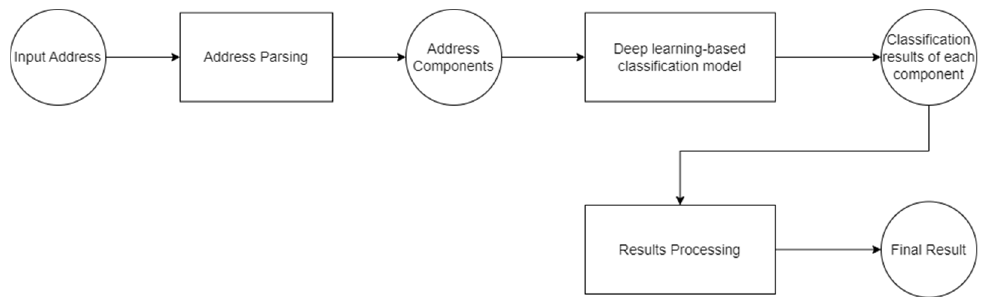
Figure 5. End-to-end address verification